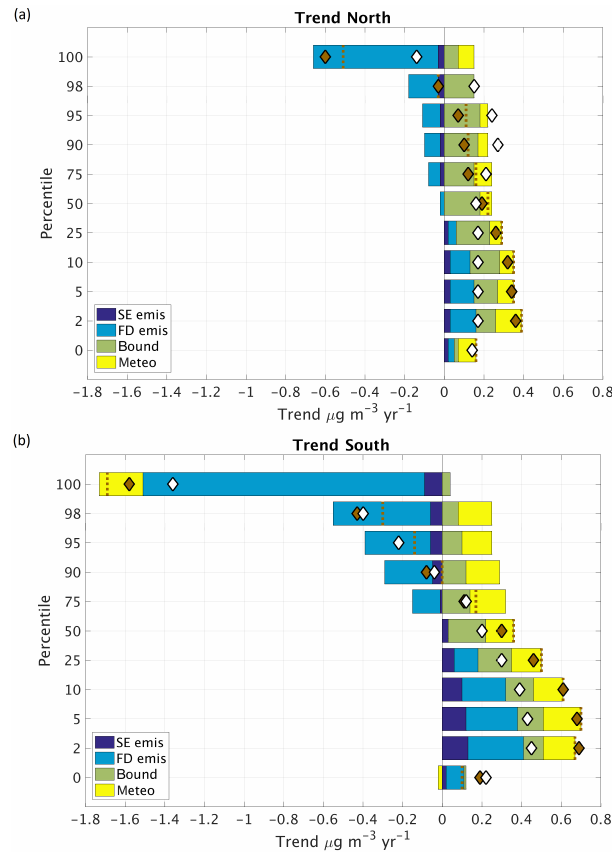
Figure 10. Linear trends over 1990–2013 in annual percentiles of hourly mean near-surface ozone concentrations for the north (a) and the south (b) Sweden regions. Reanalyzed (white diamond; LONGTERM reanalysis) and modeled MFG near-surface ozone trend (brown diamond) and modeled contributions to the near- surface ozone concentration trend due to change in emissions: an- thropogenic Swedish (dark blue, SE emis) and full domain, non- Swedish (light blue, FD emis) emissions; trend in top and lateral boundaries of relevant species (dark yellow, bound) and variation in meteorology (light yellow, meteo). The sum of the modeled contri- butions is indicated by the dashed brown line.